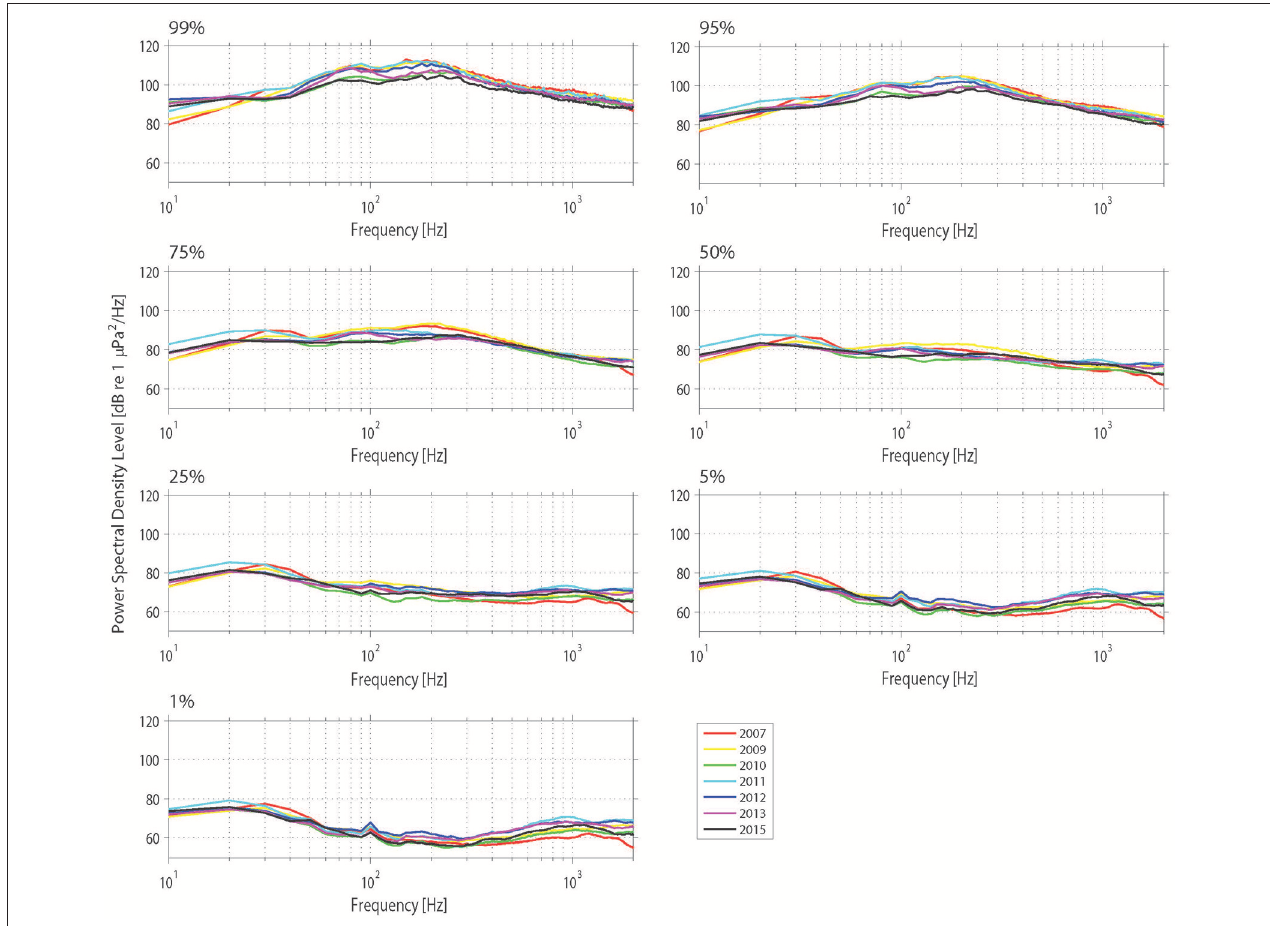
FIGURE 10 | Power spectrum density (PSD) percentiles (averaged into 10 Hz bands) at Mosman Bay over the month of January across the 9-year period considered in the temporal analysis. The n th percentile gives the level that was exceeded n% of the